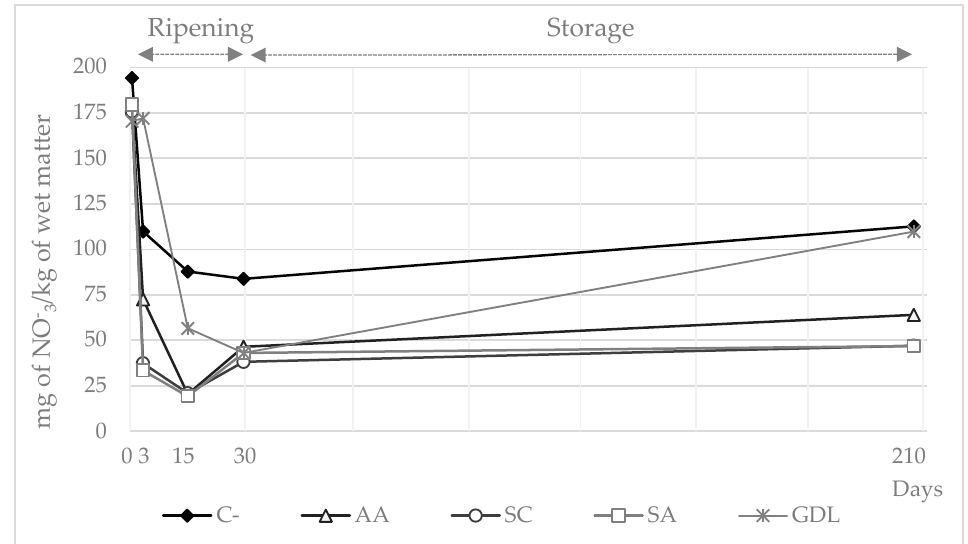
Figure 1. Nitrate concentration (mg/kg of wet matter) in sausages manufactured with different reducing agents added during ripening and storage periods (days). C- = negative control; AA = ascorbic acid; SC = starter culture; SA = sodium ascorbate; GDL = glucono-delta-lactone.